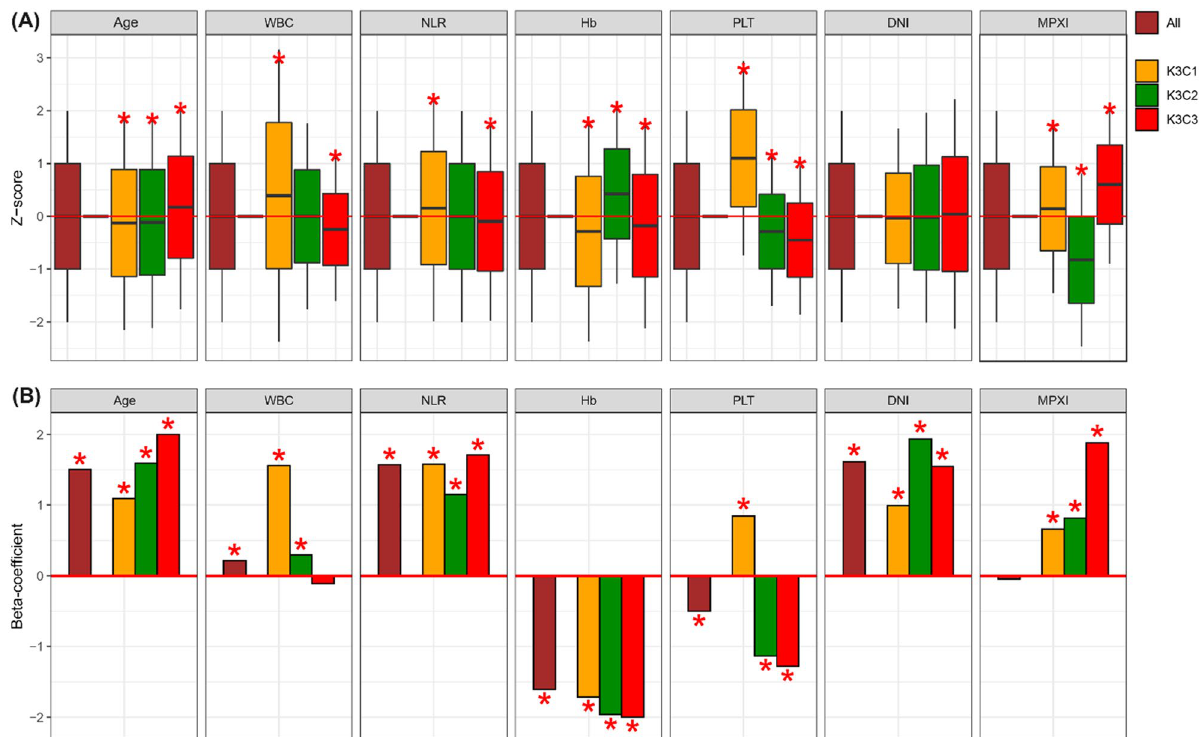
Figure 1. Three subgroups established by K-means clustering. ( A ) Three subgroups were characterized based on seven sepsis-related variables using one sample t -test. The brown box plot is about all subjects including healthy control and sepsis patients. Black middle, upper margin, and max lines in each boxplot indicate means, one standard deviation (SD), and 2-SD levels. ( B ) Beta-coefficients were measured from multivariate logistic regression. Brown bar was made by logistic regression for all subjects. Other bars (yellow, green, red) were curated by logistic regression for each cluster-specific subjects. A red asterisk indicates p -value less than